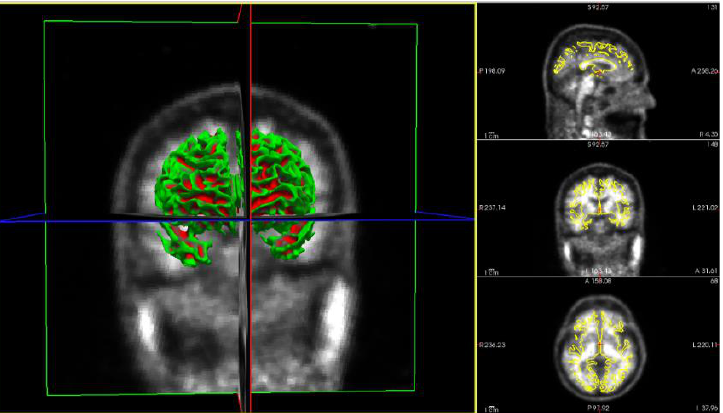
Figure 5. MRI-PET image registration after PVC of the same patient from Figures 3 and 4, which will permit us to obtain the values of SUVR for the same patient, where different colors identify different MRI brain regions.